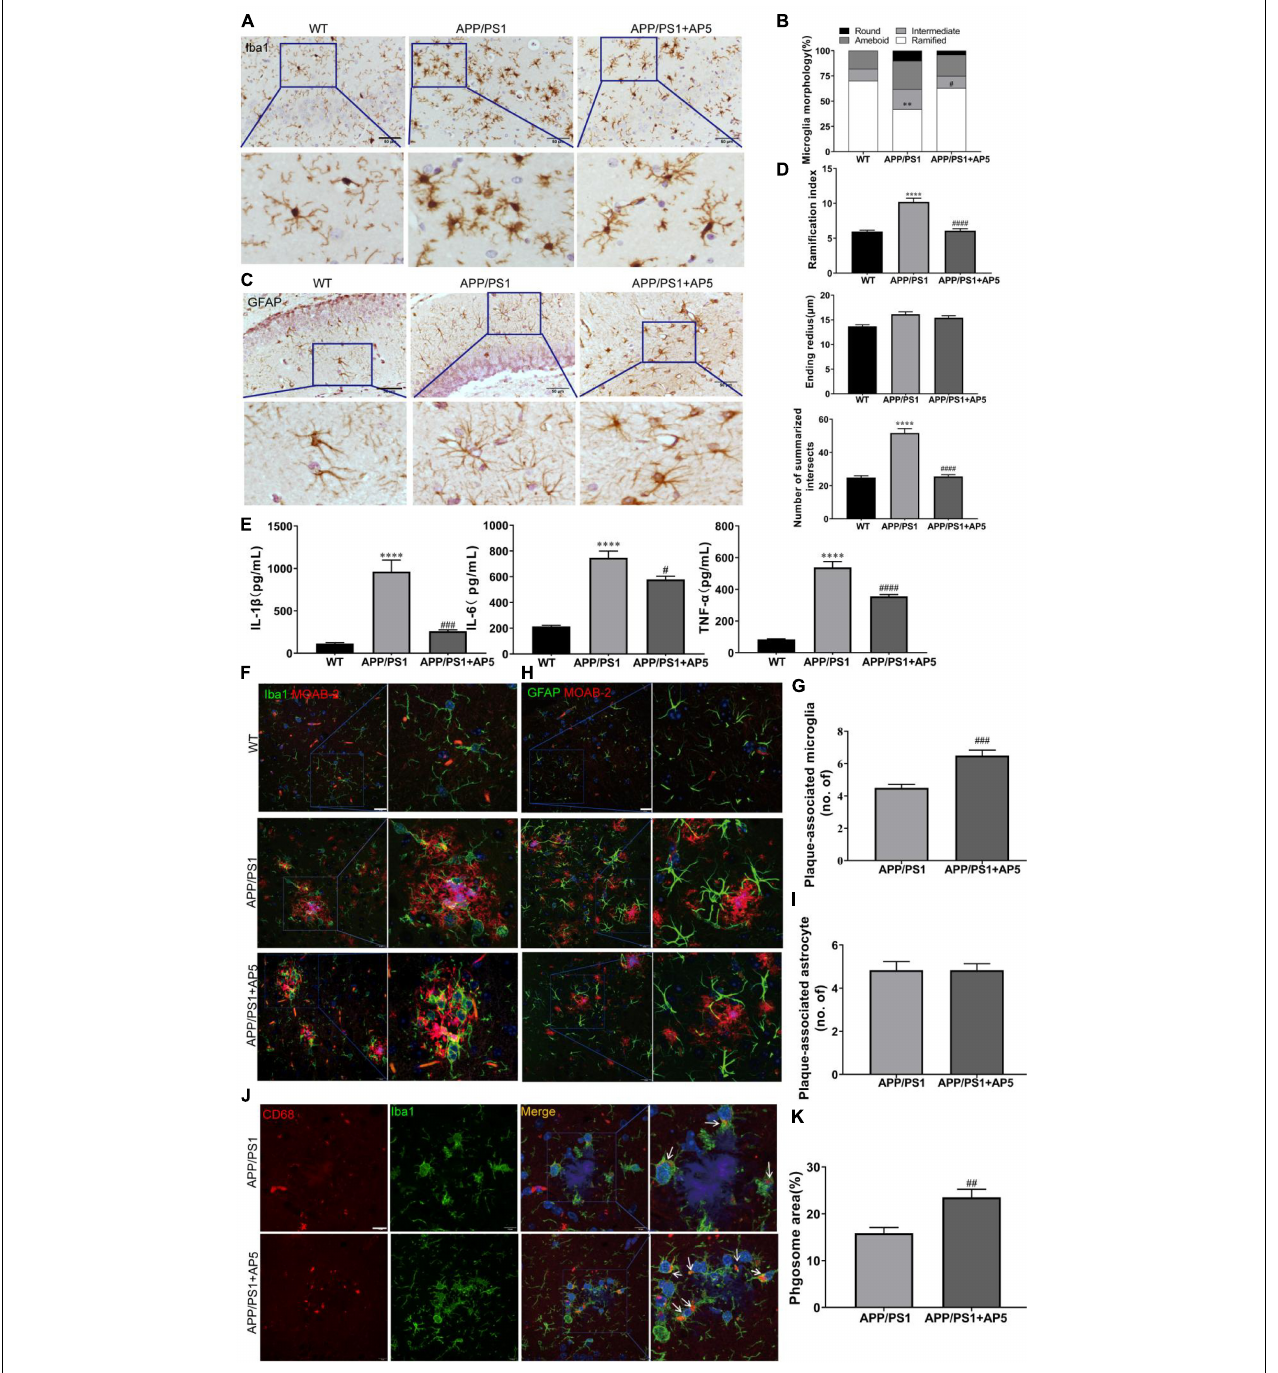
FIGURE 5 | AP5 attenuates the neuroinflammation state of APP/PS1 mice. (A) Representative images of Iba1 immumohistochemistry staining from WT, APP/PS1, and AP5 mice. Scale bar: 50 µ m. (B) Quantification of morphological classification in Iba1 positive microglial cells. (C) Representative images of GFAP immumohistochemistry staining from WT, APP/PS1, and AP5 mice. Scale bar: 50 µ m. (D) Quantification of the summarized intersects, ramification index, and ending radius in GFAP positive astrocytes. (E) The levels of TNF- α , IL-6, and IL-1 β . ** P < 0.01, **** P < 0.0001 compared with WT mice, # P < 0.05, ### P < 0.001, #### P < 0.0001 compared with APP/PS1 mice by one-way ANOVA followed by a Tukey’s post hoc test, n = 6 mice per group. (F) Representative images of MOAB-2 and Iba1 co-staining and (G) quantification of the number of plaque-associated microglia from APP/PS1 and AP5 mice. Scale bar: 20 µ m. (H) Representative images of MOAB-2 and GFAP co-staining and (i) quantification of the number of plaque-associated astrocytes from APP/PS1 and AP5 mice. Scale bar: 20 µ m. (J) Representative images of CD68 and Iba1 co-staining and (K) quantification of CD68 area within microglia from the APP/PS1 and AP5 mice. Scale bars: 20 µ m. ## P < 0.01, ### P < 0.001 compared with APP/PS1 mice by unpaired t-test, n = 6 mice per